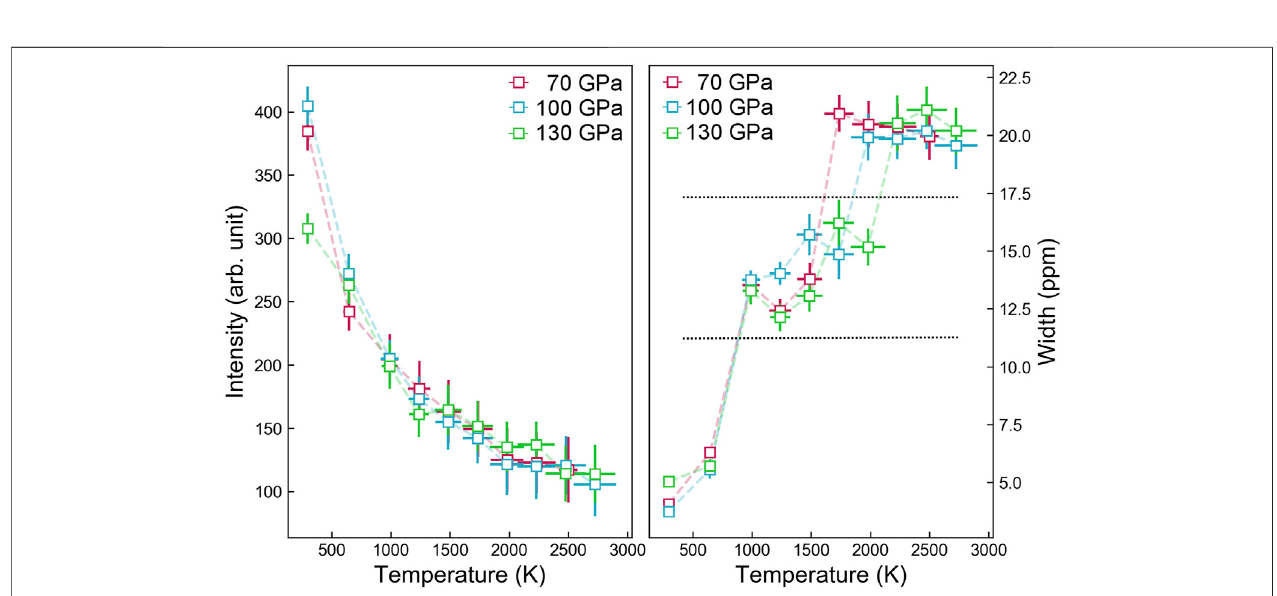
FIGURE2| TraceofHchemicalshiftunderpressureandtemperature.TheleftandrightpanelsaretheintensityandwidthoftheNMRpeakofFeO 2 H,respectively. The hierarchical changes in peak width are due to the temperature response of the O-H-O hydrogen bond, which evolves from symmetric to asymmetric bonding and eventually to the